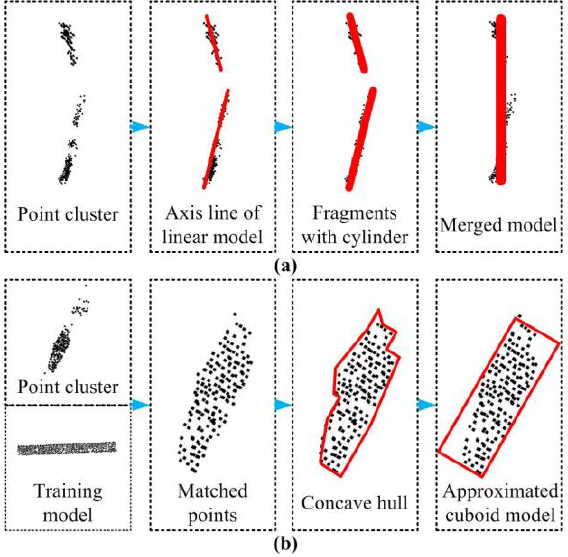
Figure 5. a) The procedure of modelling the tube, b) the procedure of modelling the